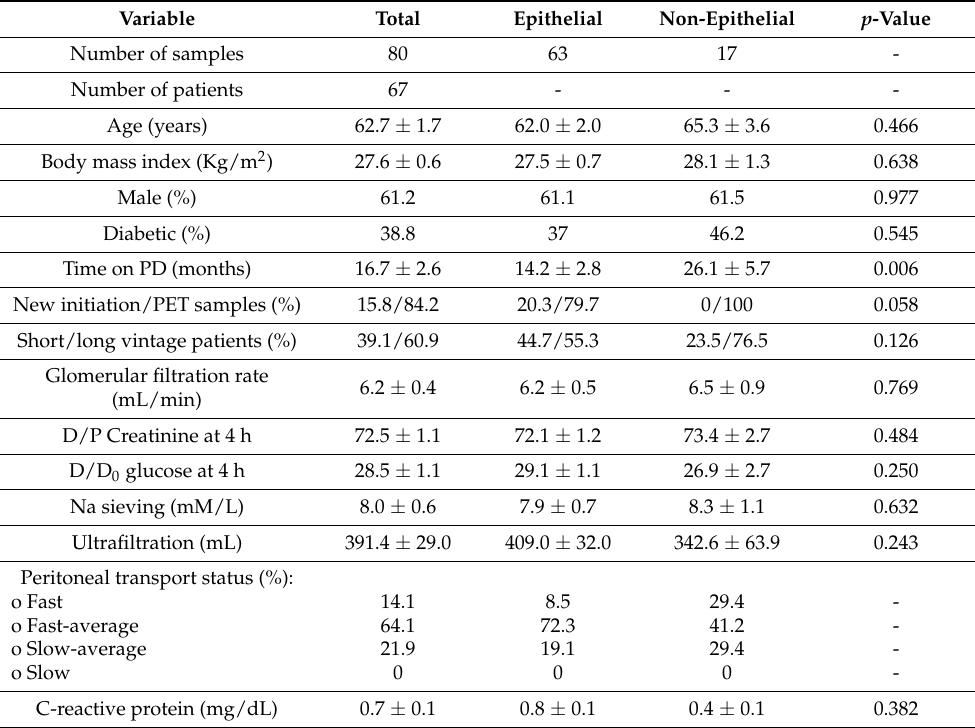
Table 1. Study population characteristics according to the morphology of effluent-derived mesothelial